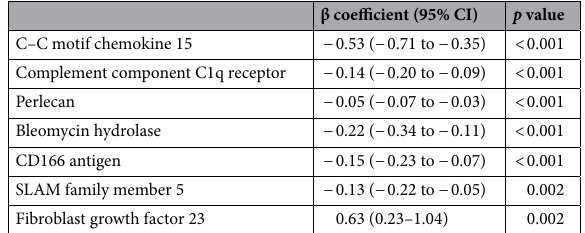
Table 2. Associations of free form indoxyl sulfate and selected cardiovascular protein biomarkers in the multivariate linear regression model. Associations of baseline free form indoxyl sulfate with selected protein biomarker NPX value using multivariate linear regression model adjusting for age, sex, hemodialysis duration, cause of end-stage renal disease, arteriovenous shunt type, comorbidities (diabetes mellitus, hypertension, and dyslipidemia), medications (antiplatelet/warfarin, anti-hypertensive drugs, diabetic treatment drugs), and laboratory data (calcium, phosphate, high sensitivity C-reactive protein, and